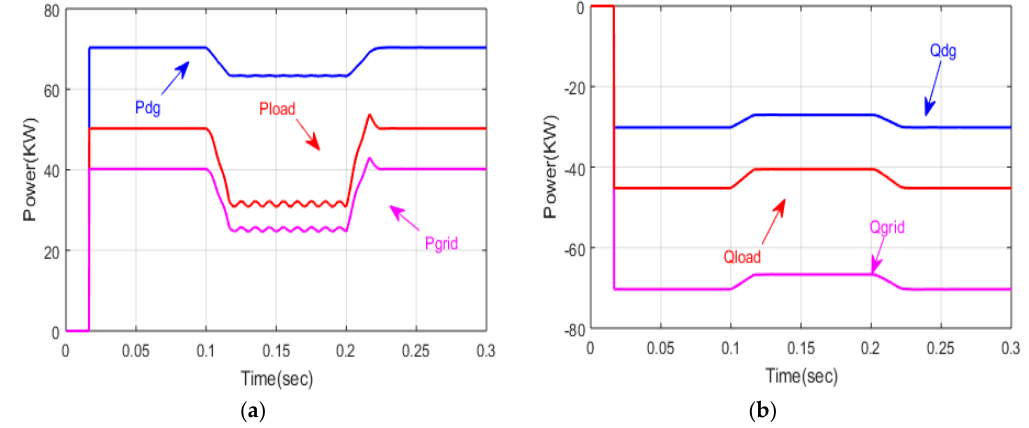
Figure 11. ( a ) Active Power, ( b ) Reactive power.